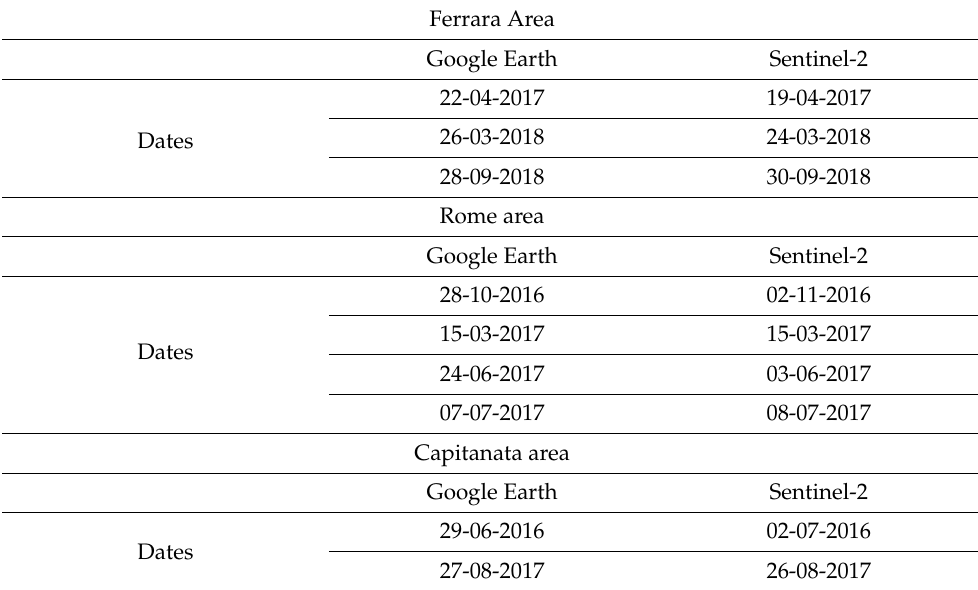
Table 2. Retrieved dates related to the comparable images between Google Earth Pro and Sentinel-2 bare soil frequency